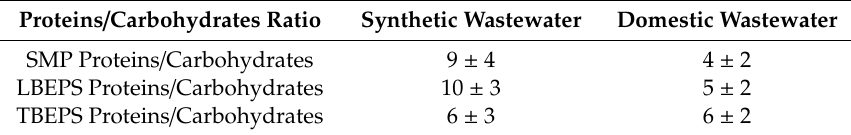
Table 4. Comparison of proteins / carbohydrates ratio for SMP and EPS between synthetic and domestic